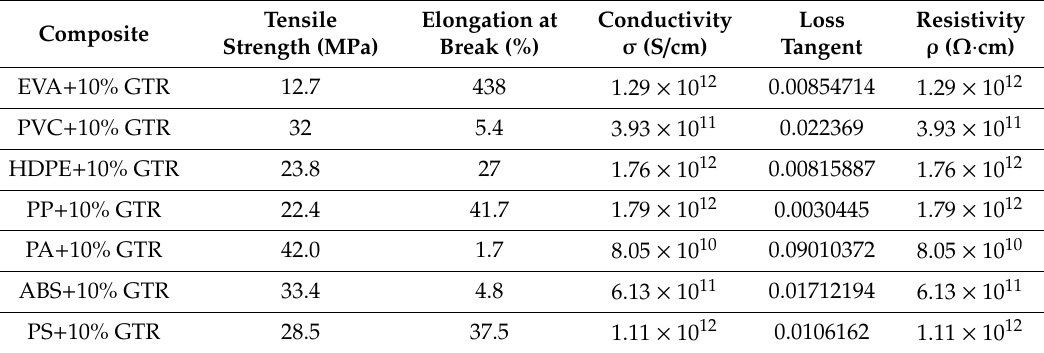
Table 5. Mechanical and electrical test results with 10%